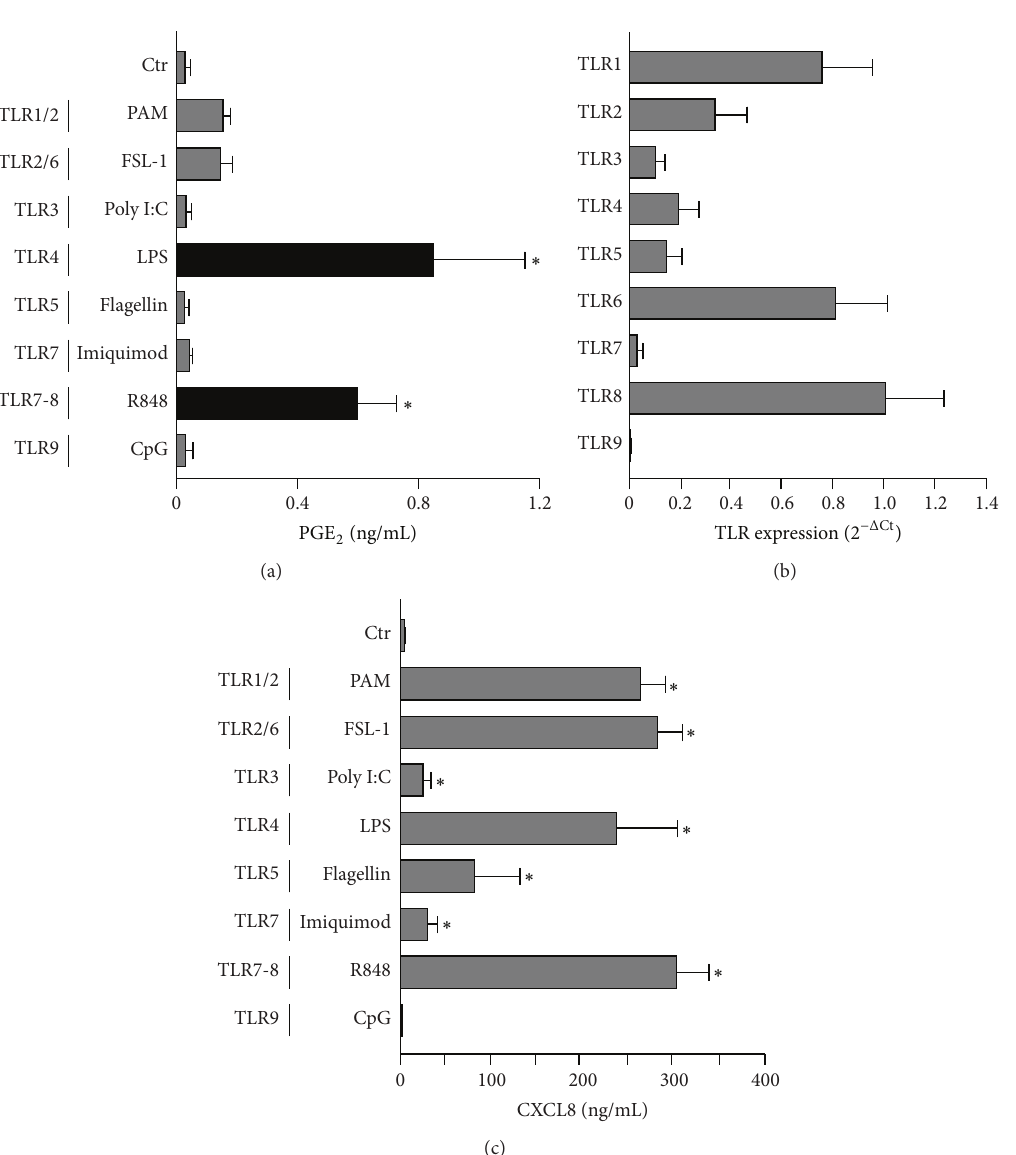
Figure 1: TLR4 and TLR7-8 stimulation induce the secretion of PGE 2 by DCs. ((a) and (c)) DCs at day 6 of culture were stimulated with PAM 3 CSK 4 (100ng/mL), FSL-1 (100ng/mL), Poly I:C (25 𝜇 g/mL), LPS (100ng/mL), Flagellin (100ng/mL), Imiquimod (5 𝜇 g/mL), R848 (5 𝜇 g/mL), and CpG (6 𝜇 g/mL). After 24 h, supernatants were collected and the production of PGE 2 (a) and CXCL8 (c) was evaluated by EIA or ELISA, respectively. Results are expressed as mean ± SEM ( 𝑛 = 4 ); ∗ 𝑃 < 0.05 compared with respective controls by one-way ANOVA with Dunnett’s post hoc test. (b) mRNA from DCs at day 6 of culture was extracted to analyse the expression of TLRs. Data are expressed as mean ± SEM ( 𝑛 = 3